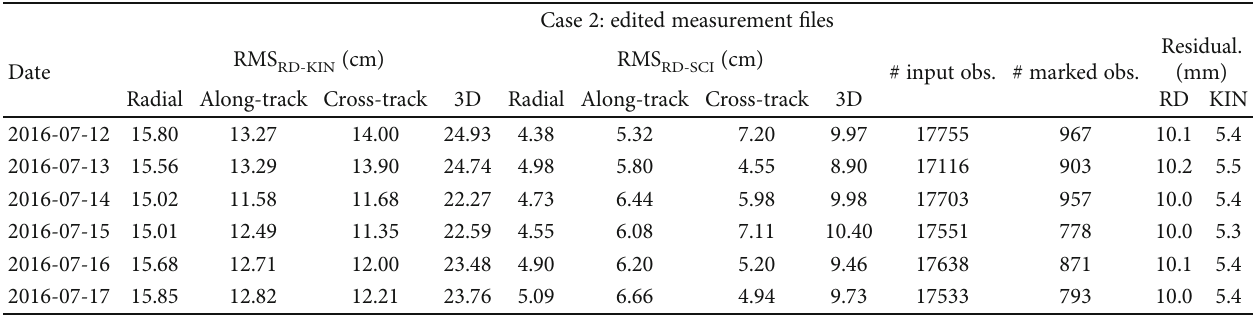
Table 5: POD results for KOMPSAT-5 without GPS observations during attitude maneuvers. Case 2: edited measurement fi